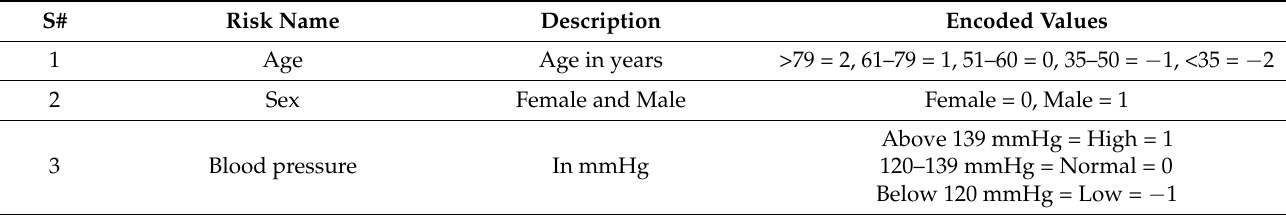
Table 2. Detailed Description of